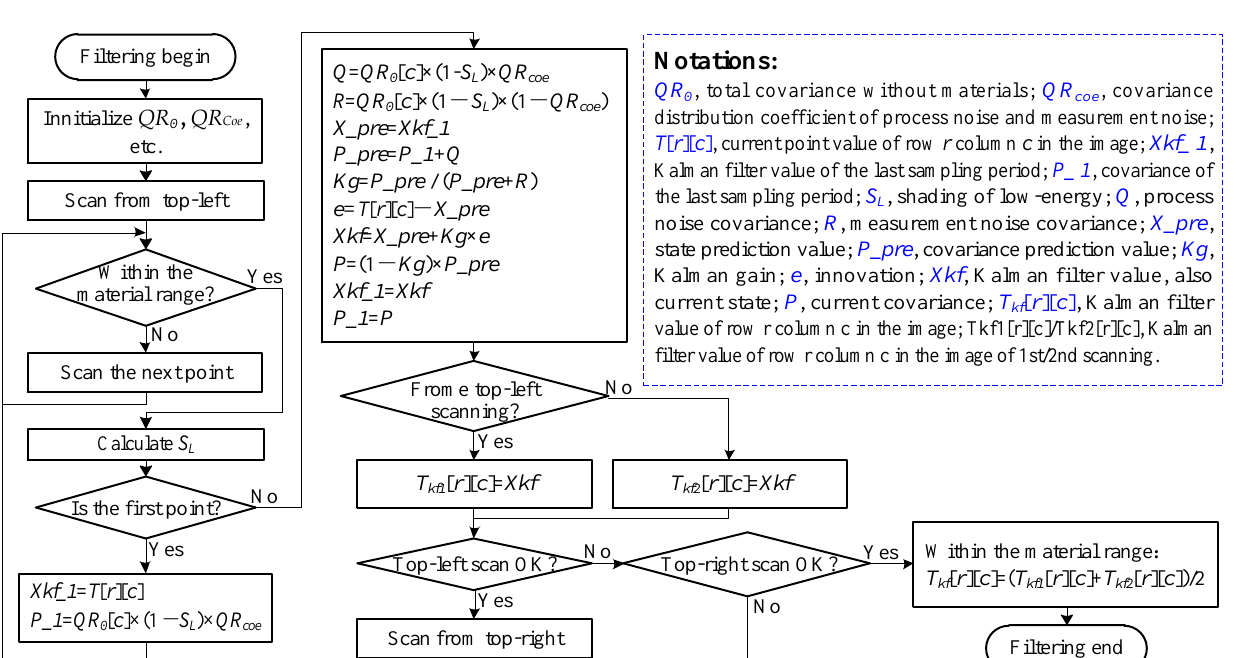
Figure 3. Schematic diagram of calculation scanning mode.